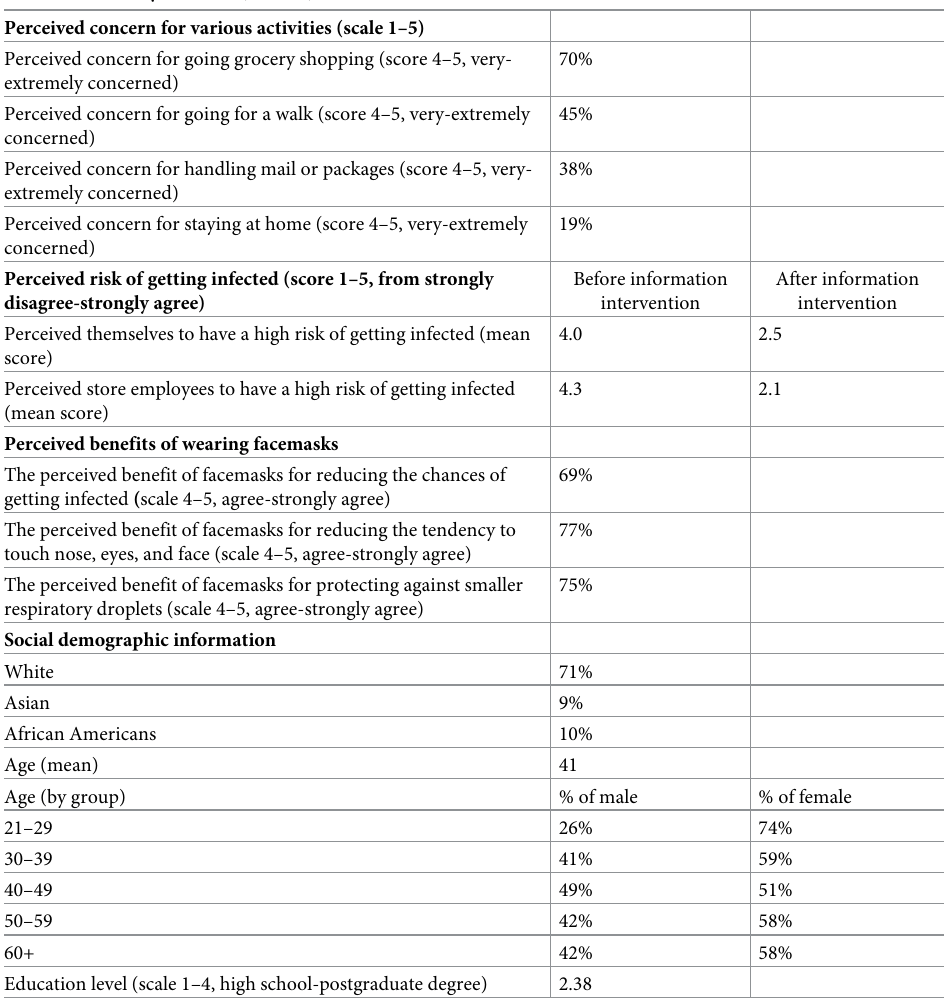
Table 1. Summary statistics (n =